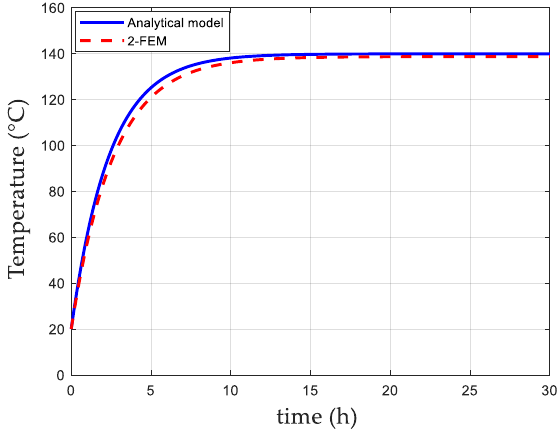
Table 7. Losses of the optimal generator at the maximal power (10 MW, 1.03 kA).